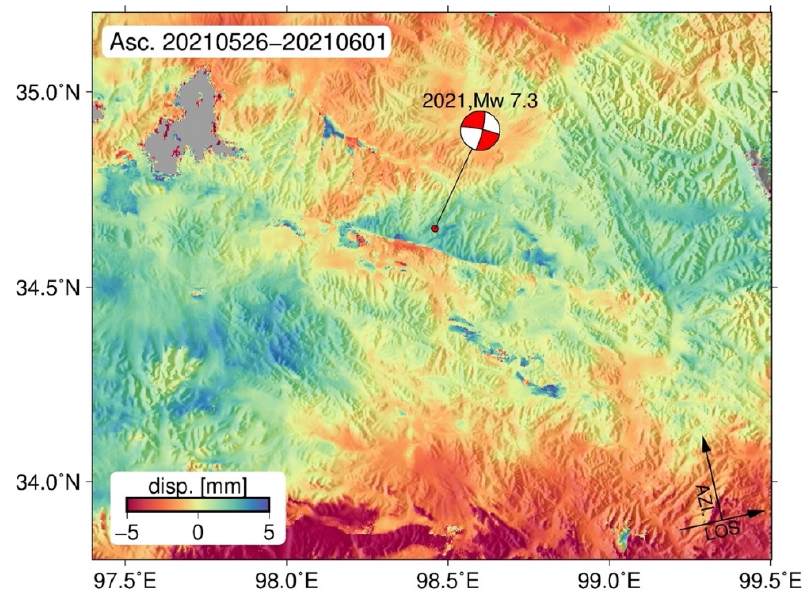
Figure 9. Postseismic deformation following the Maduo earthquake observed by Sentinel-1 SAR images on ascending track.